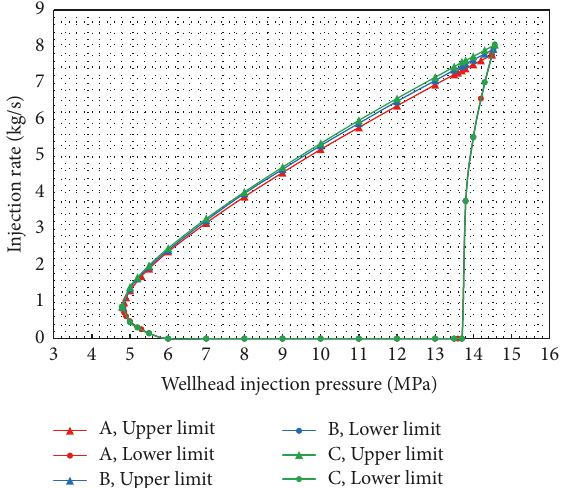
Figure 11: Relationship diagram between wellhead injection pres- sure and injection rate at different reservoir porosity.